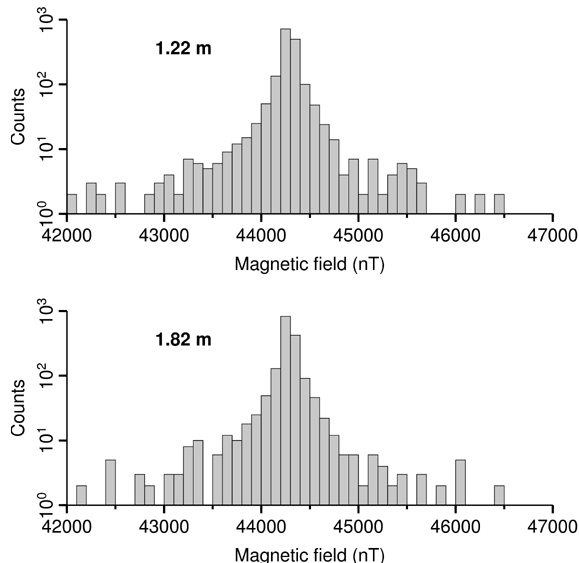
Fig. 3. Histograms of raw magnetic readings measured at heights of 1.22 (upper panel) and 1.82 (lower panel) m above the ground. Note that there are two groups of data points, at the high and low ends, in both